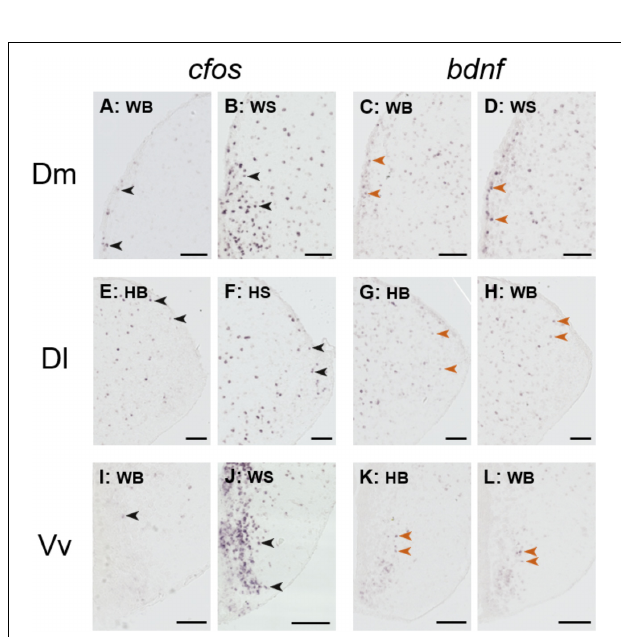
FIGURE 6 | Representative example of in situ hybridization of cfos and bdnf; images used for the quantification analysis. Representative pictures of the expression of cfos (A , B , E , F , I , J) and brain-derived neurotrophic factor ( bdnf ; C , D , G , H , K , L ) transcripts ( purple cells) in the dorsomedial pallium (Dm; A–D ), dorsolateral pallium (Dl; E–H ), and ventral part of the ventral telencephalon (Vv; I–L ) of wild and hatchery-reared Atlantic salmon parr under basal or after acute stress conditions. WB, wild basal; WS, wild stress; HB, hatchery-reared basal; HS, hatchery-reared stress. Arrows indicate transcript-labeled cells and all scale bars measure 100 µ